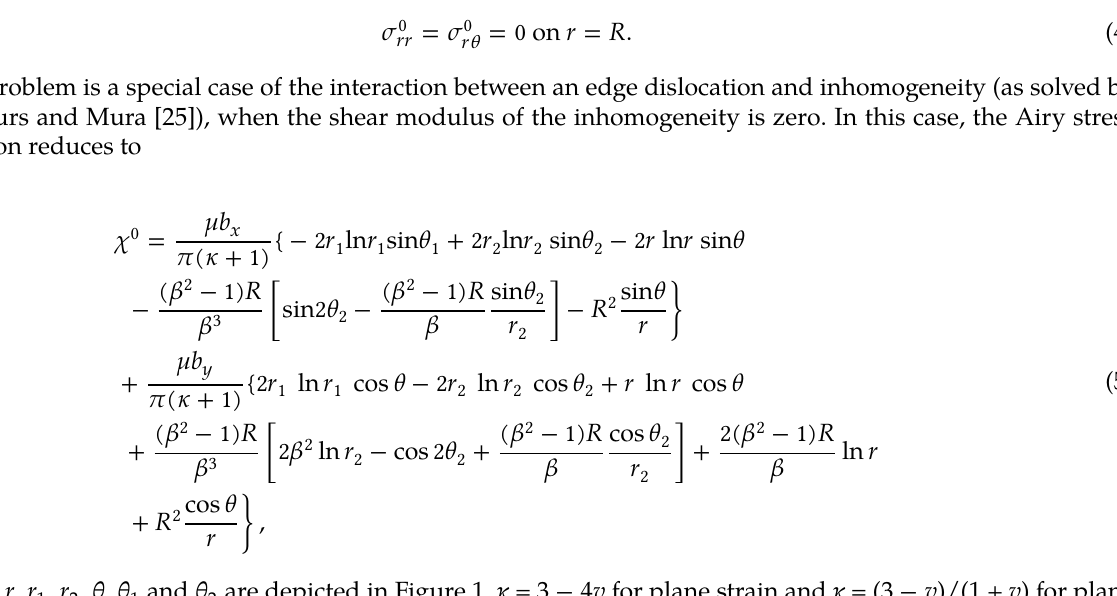
𝜎 0 = 𝜎 0 = 0 on 𝑟 = 𝑟𝑟 𝑟𝜃